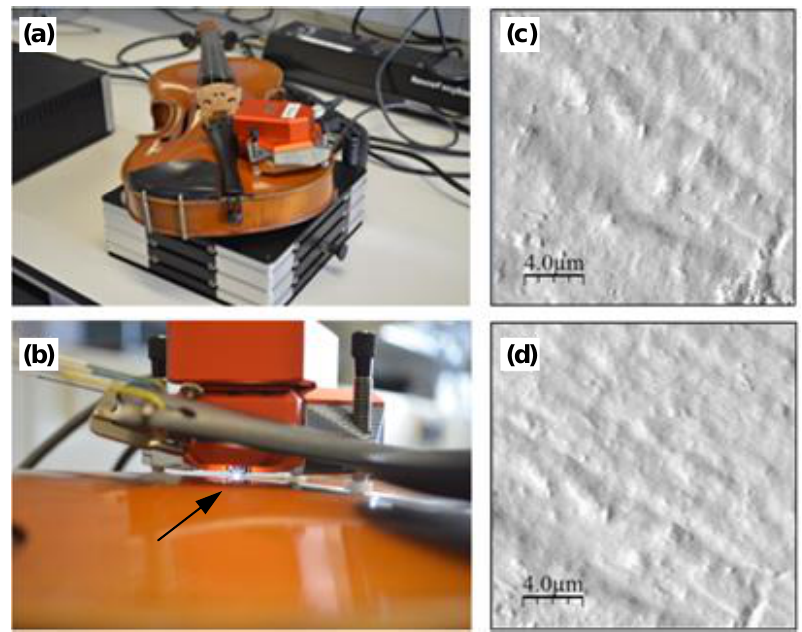
Figure 1. ( a ) Nanosurf Easyscan 2 AFM head on a violin placed on an anti-vibration table ( b ) closer view of AFM head on the violin placed on plastic spacers to protect the surface of the violin and showing location of the AFM tip (black arrow) ( c , d ) AFM images (20 μ m × 20 μ m) recorded directly on the violin surface in two different locations [location ( c ) z-scale image = 1.28 µ m/Roughness Ra 0.176 μm; location ( d ) z-scale image = 2.03 μm /Roughness Ra 0.291 μm ].